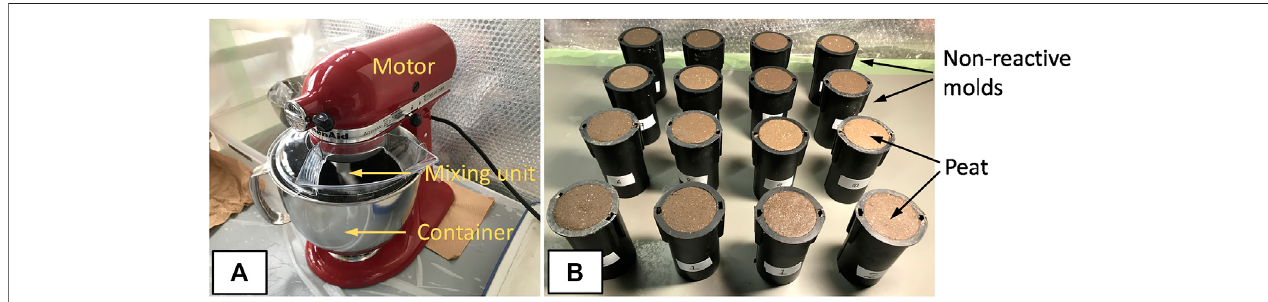
FIGURE 2 | Preparation of amorphous peat specimens: (A) mechanical mixer and (B) specimens placed into nonreactive cylindrical molds of 50 mm in diameter and 100 mm in height.